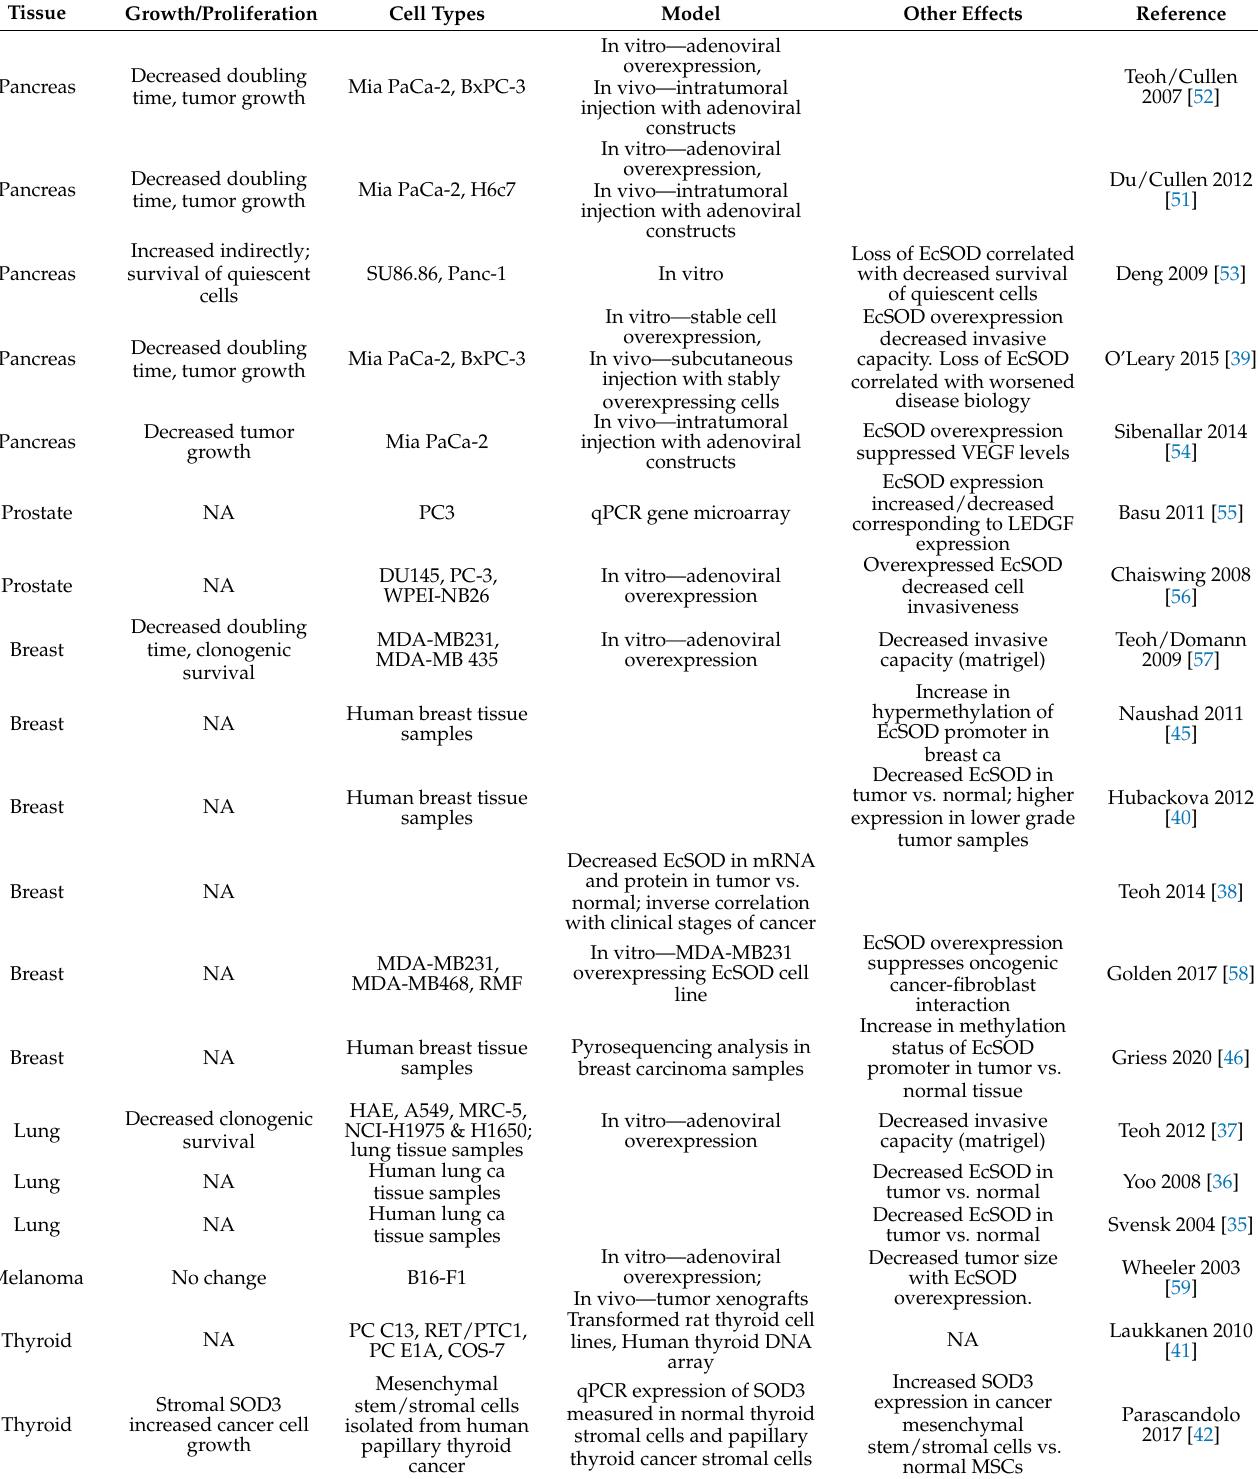
Table 1. EcSOD in